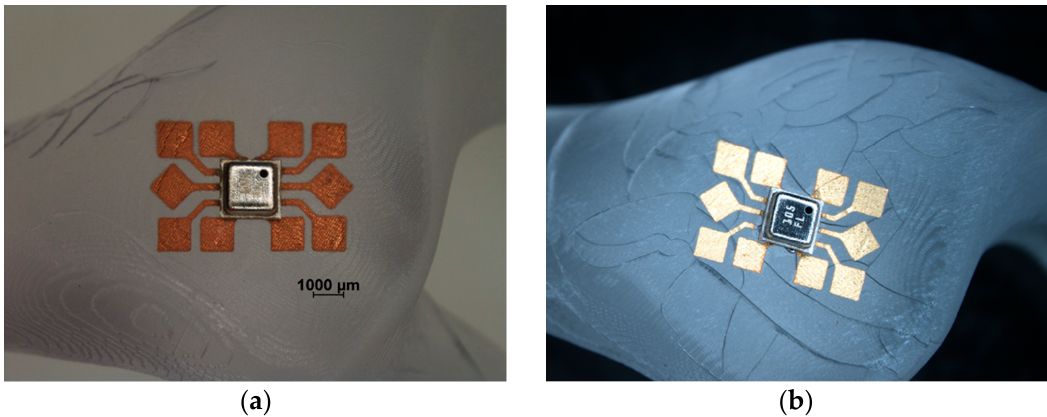
Figure 14. Soldering of 0603 SMD with SnBi solder at 180°C on aerosol jet printed Ag structures after electroless copper plating (substrate: Luxaprint 3D mold). Plating time 60 min ( a ) and 15 min ( b ).